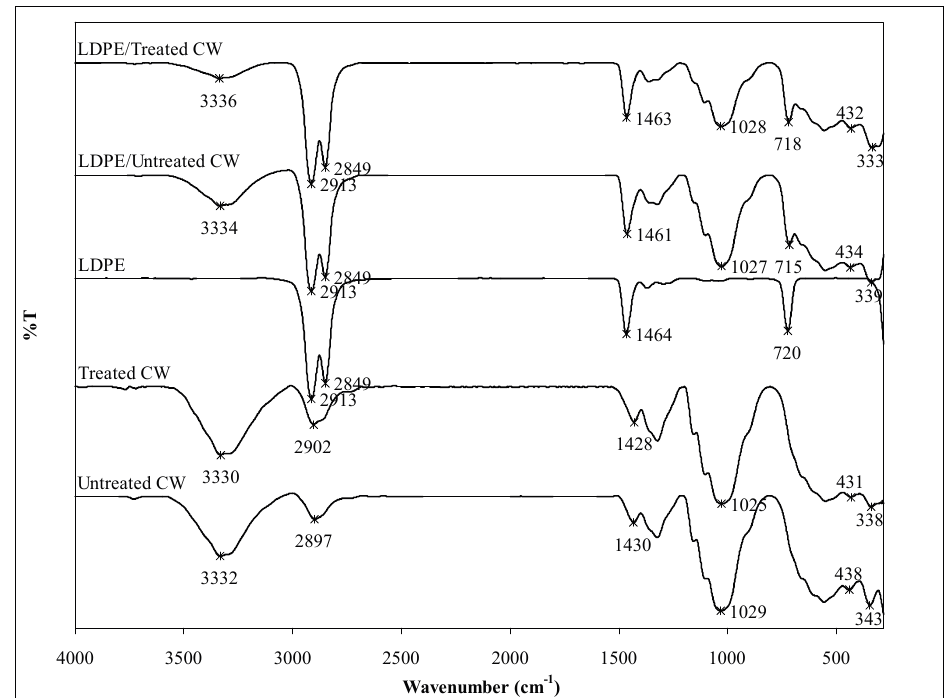
Figure 5. FTIR spectra of the untreated CW, treated CW, LDPE, LDPE/untreated CW and LDPE/treated CW